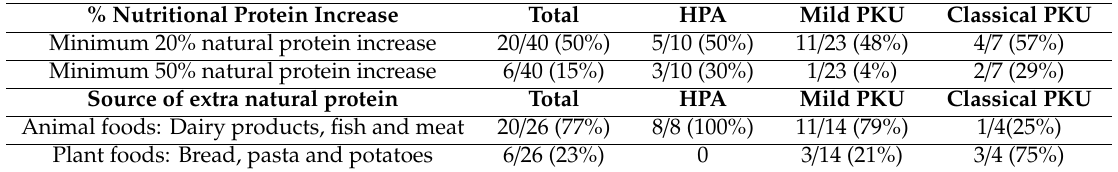
Table 3. Number of subjects with natural protein increase by disorder